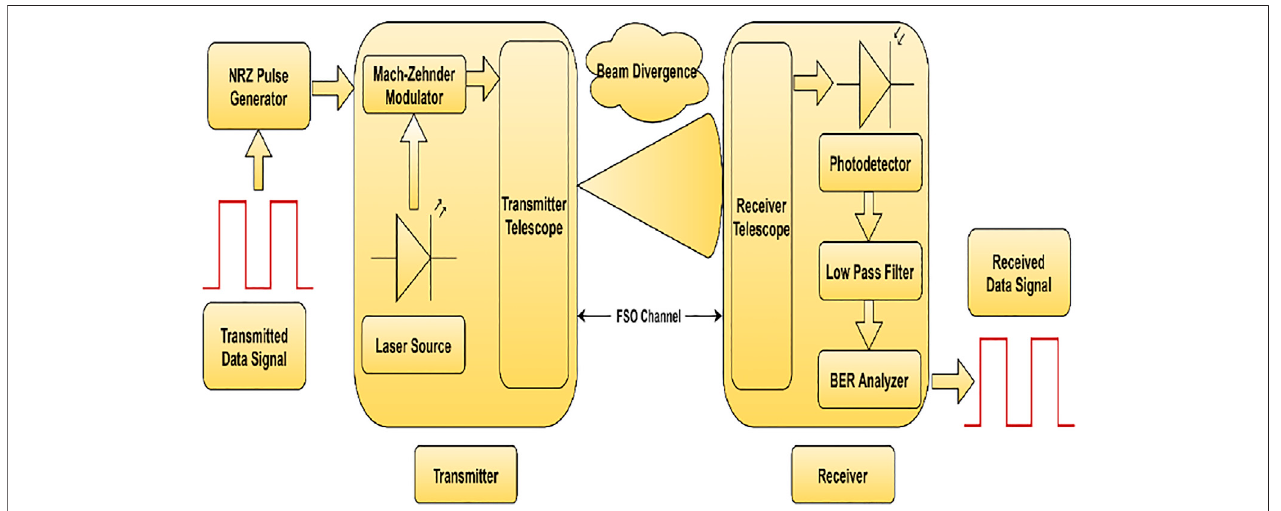
FIGURE 2 | Proposed system design of commercial applications-based FSO communication system.